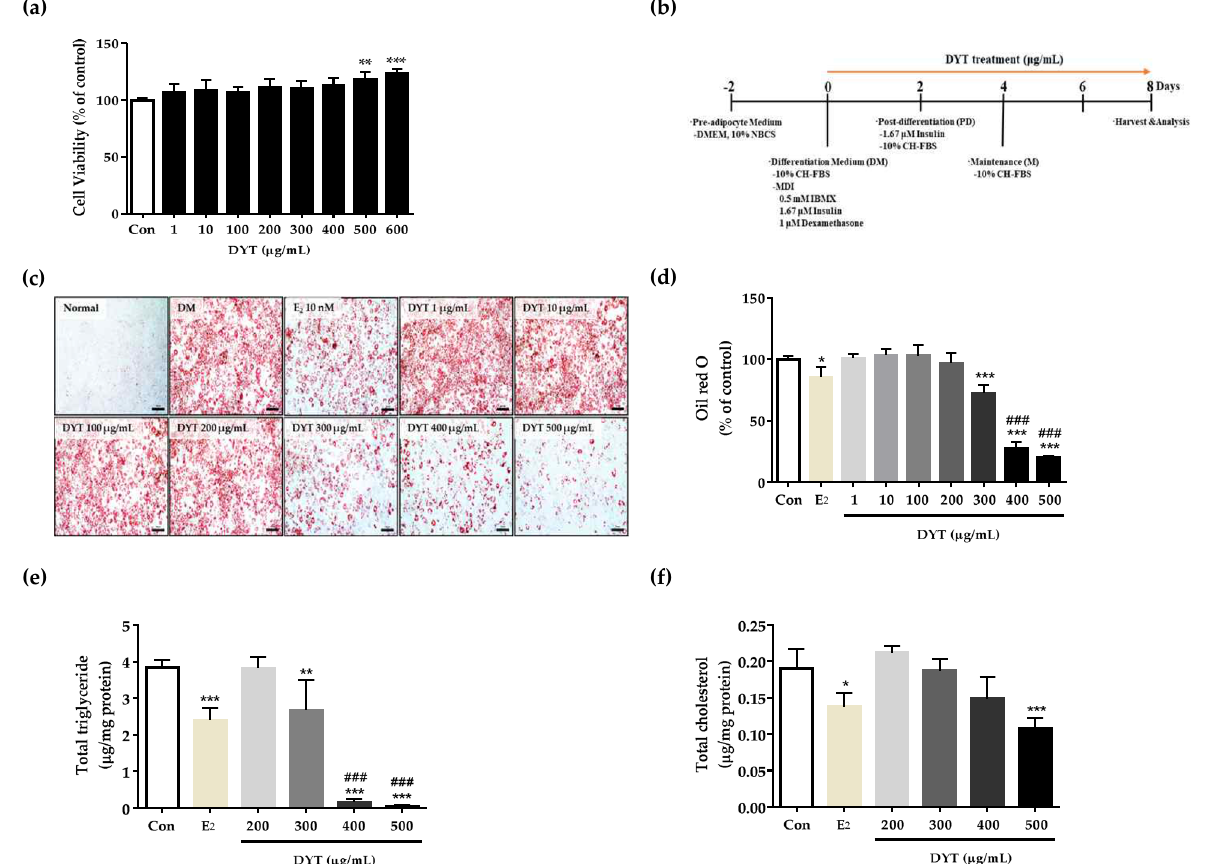
Fig. 2 Effect of DYT on cell viability and anti‑adipogenesis in 3T3‑L1 cells. Cell viability by DYT in 3T3‑L1 cells ( a ). Data are presented as mean of four experiments. ** p < 0.01, *** p < 0.001 vs. control. A brief overview of 3T3‑L1 differentiation ( b ). Optical microscope images of intracellular lipid droplets of differentiated 3T3‑L1 cells ( 200) ( c ). Graph representing the quantification of lipid accumulation in each treatment group ( d ). Data are × presented as mean SD of four experiments. * p < 0.05, *** p < 0.001 vs. control, ### p < 0.001 vs. E 2 . The quantification of total triglyceride (TG) for ± each treatment group ( e ). The quantification of total cholesterol (TC) for each treatment group ( f ). The results are presented as the